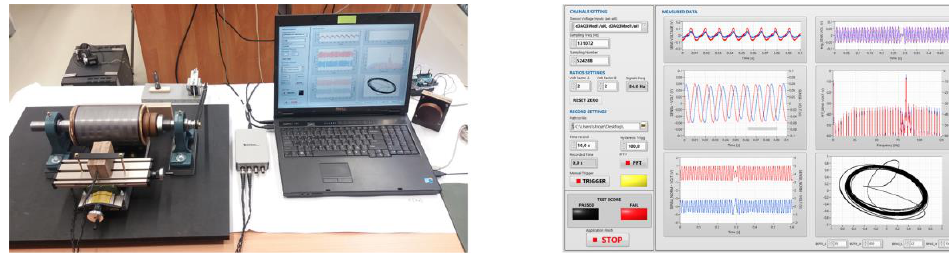
Figure 16. Completed experimental setup with visualization panel in LabView.